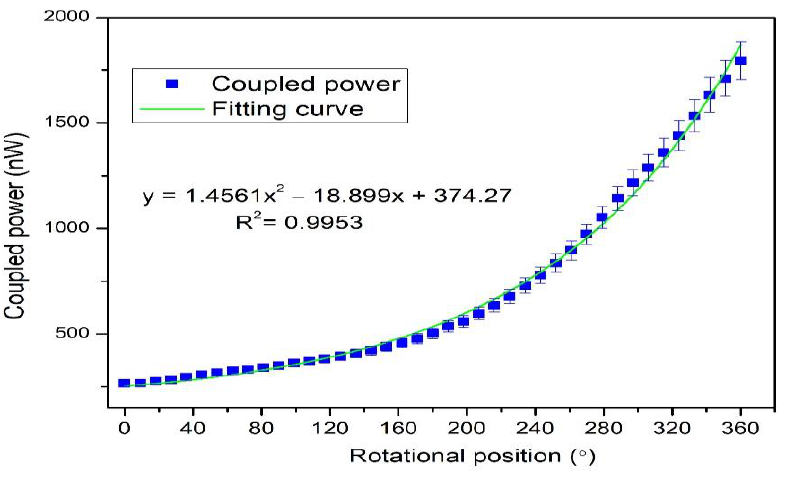
Figure 4. The anti-clockwise measurement of the rotational sensor.